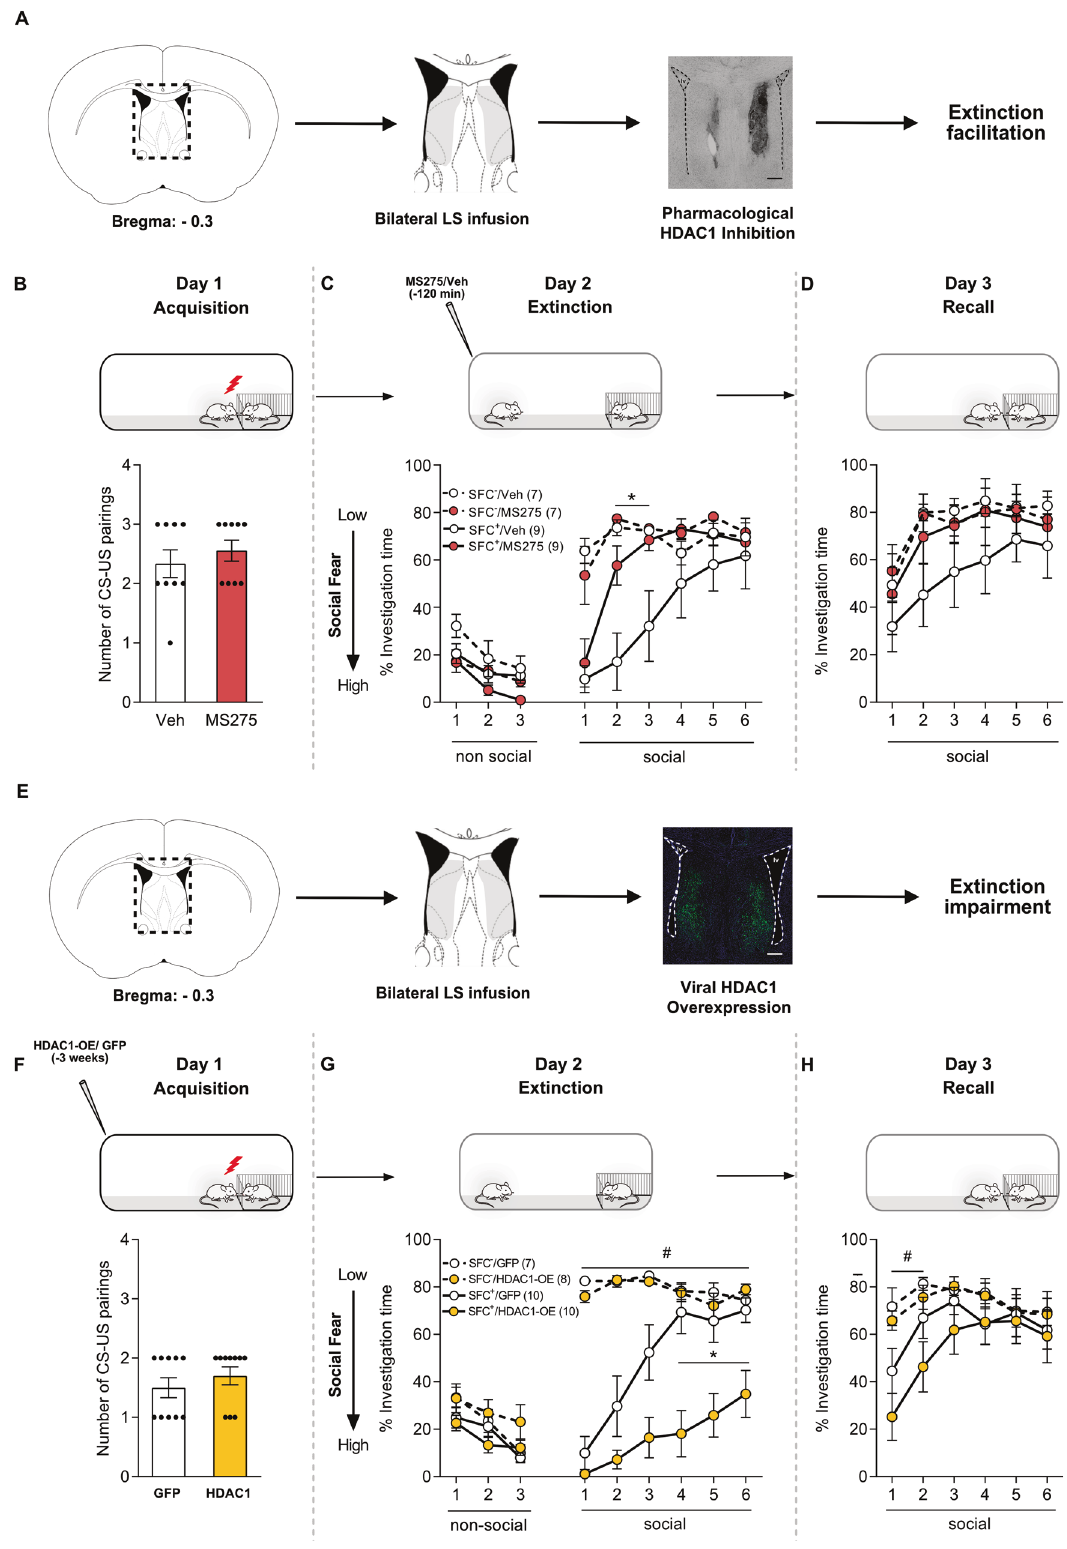
blockade (loss of function) or an AAV-mediated overexpression (gain of function) in two separate cohorts of mice. For pharmacological blockade of LS-HDAC1, MS275 or Veh was bilaterally infused into the LS prior to extinction training leading to the following groups: SFC + /Veh, SFC + /MS275, SFC − /Veh,